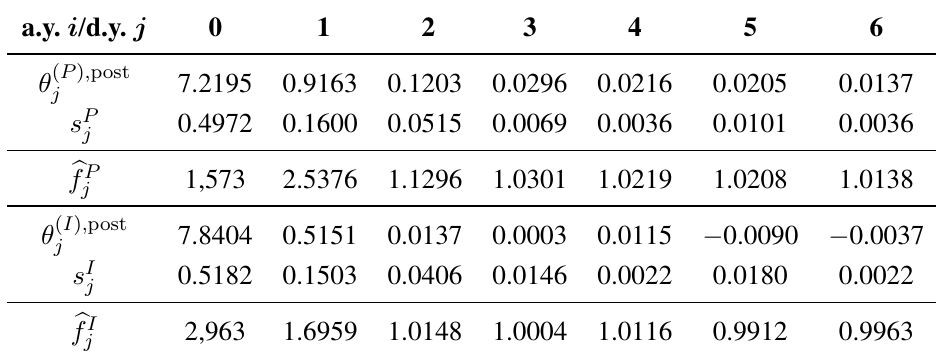
Table 1. Sample standard deviations s P obtained from Corollary 3, see also Equation (21); and Hertig’s chain-ladder estimates (cid:98) f P according to Equation and (cid:98) f I j